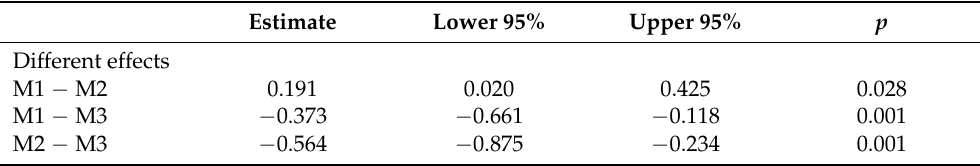
Table 6. Comparison of mediating